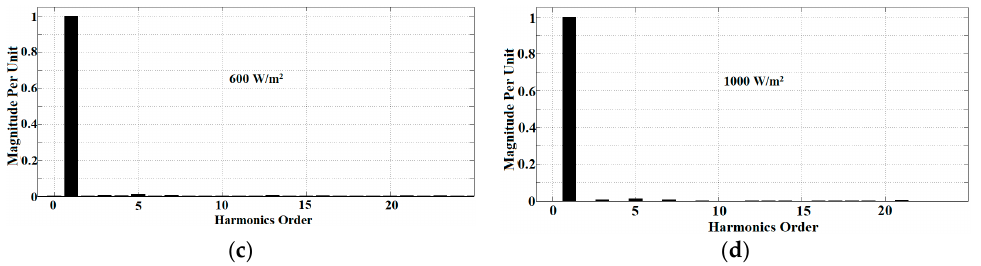
Figure 9. Simulation results of harmonic spectra for inductive load using the Modified W-H ADALINE algorithm at ( a ) 0 W/m 2 (without PV), ( b ) 200 W/m 2 , ( c ) 600 W/m 2 , and ( d ) 1000 W/m 2 .